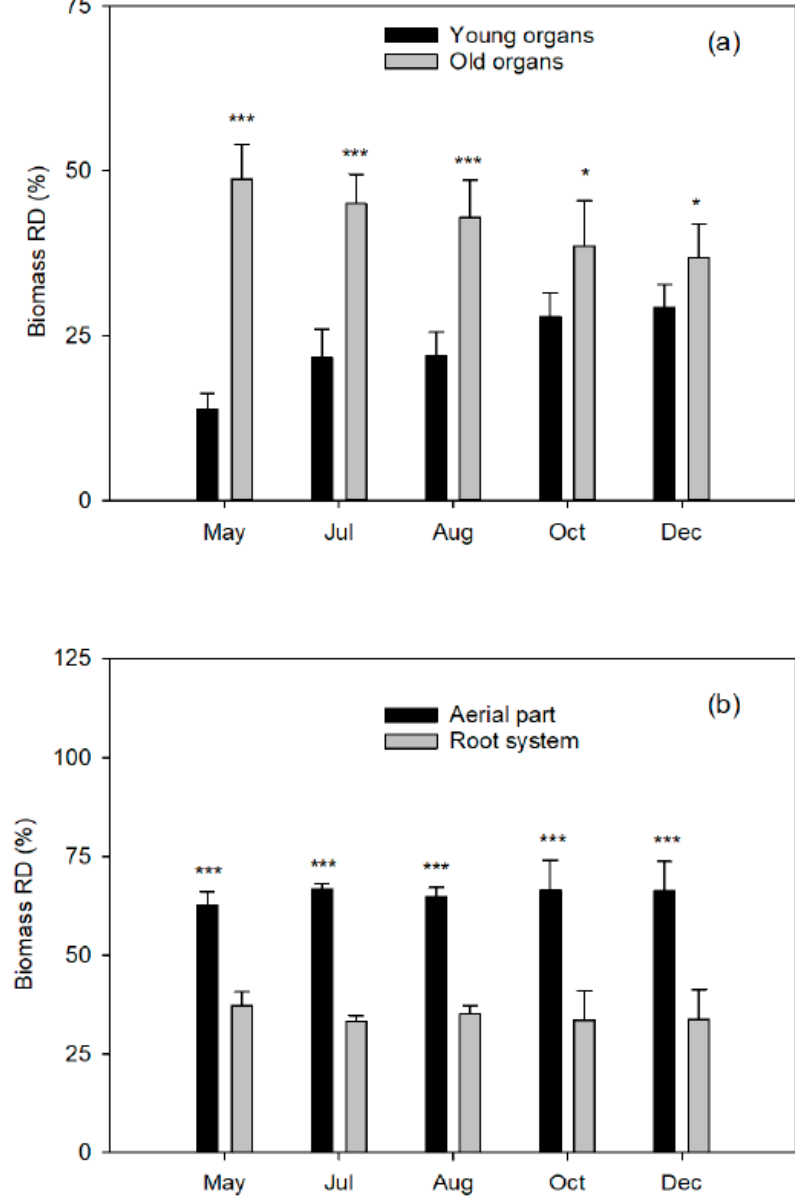
Figure 1. Relative distribution (%) of dry-biomass (RBD) in ( a ) young Z and old Y organs from the aerial part in relation to the whole plant and ( b ) total aerial part and root system X of Nules clementine trees uprooted in May (flowering), July (fruit set and the end of fruit drop), August (fruit growth), October (fruit growth), and December (fruit maturity). Values are means ± SD (n = 4). Significant effects of Fe dose are given at p ≤ 0.05 (*) and p ≤ 0.001 (***) at each harvest event. Z Young organs: May: flowers, fruits, and leaves and branches from spring flush; July and August: developing fruits and leaves and branches from spring and summer flushes; October: developing fruits and leaves and branches from spring, summer, and fall flushes; and December: mature fruits and leaves and branches from spring, summer, and fall flushes. Y Old organs: leaves and branches from the year before flushes, branches without leaves, and trunk. X Root system: coarse and fibrous roots.